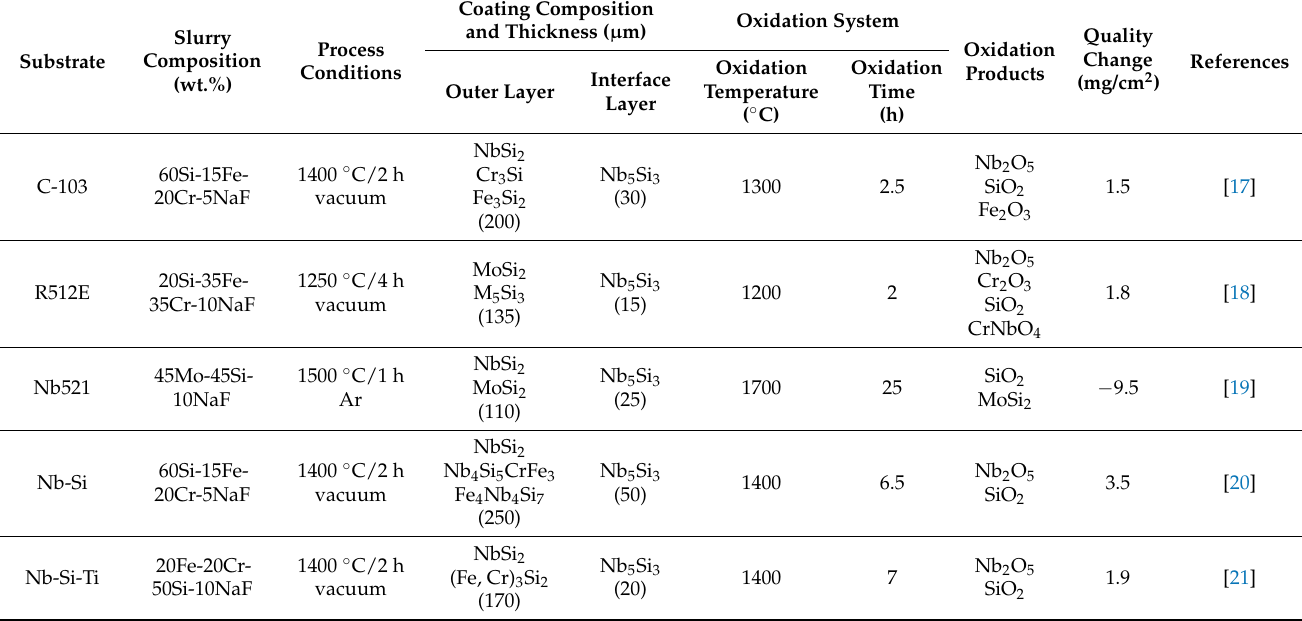
Table 1. Summary for preparation and oxidation resistance of SS coatings on Nb-based alloys.